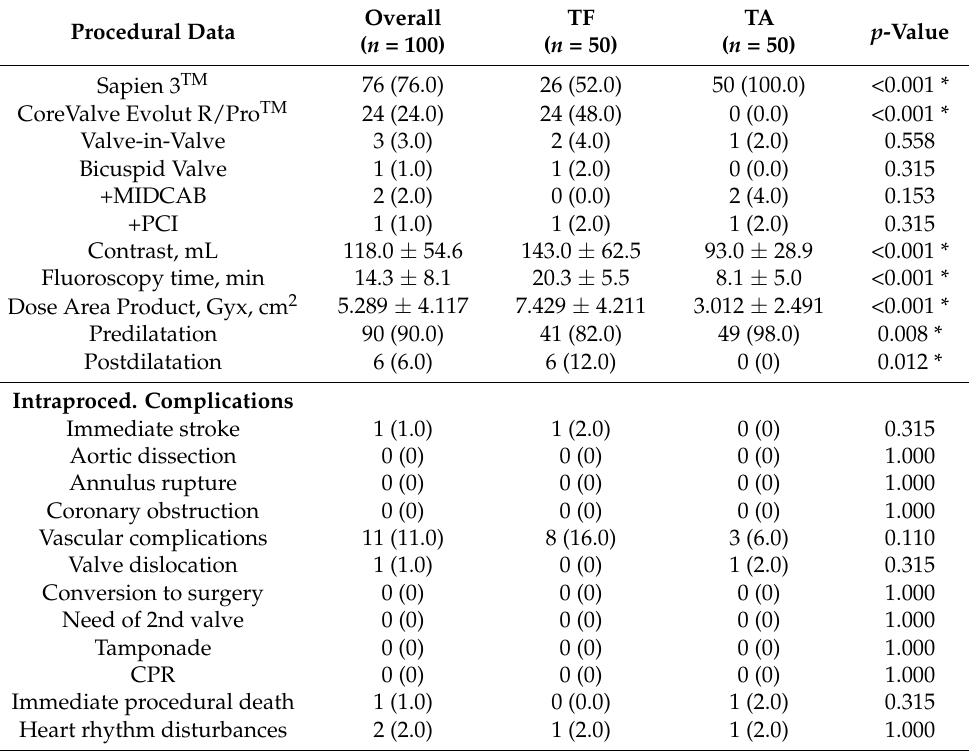
Table 2. Procedural characteristics (propensity score-matched